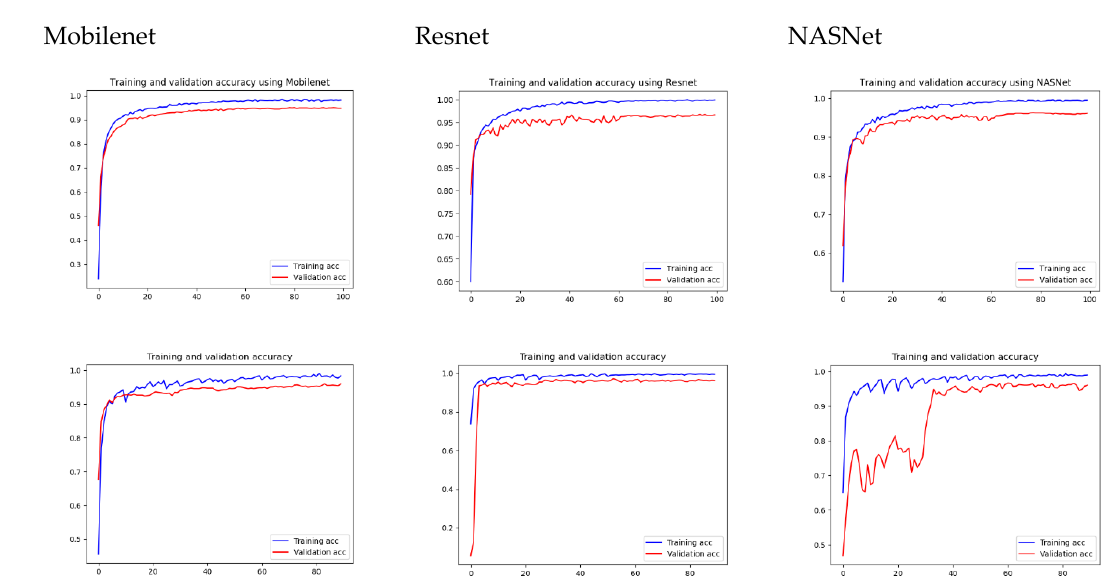
Figure 20. Performance of models trained on the PlantSeedlings dataset, using conventional training (upper row) and YMufT strategies (lower rows).